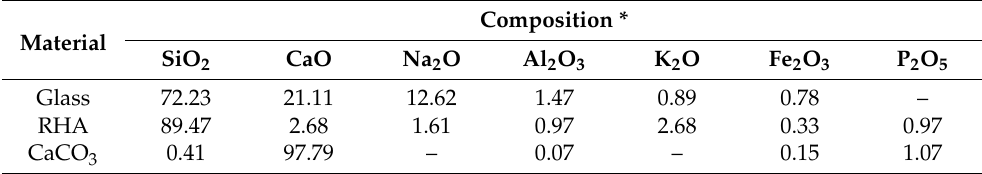
Table 1. Chemical analyses of glass, RHA, and CaCO 3